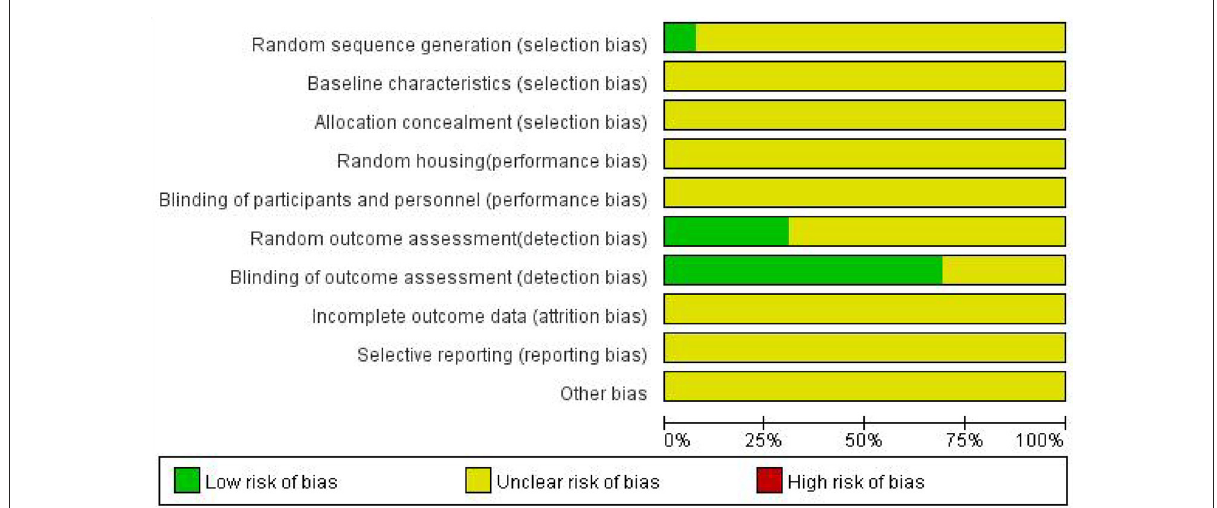
FIGURE2 Risk of bias.